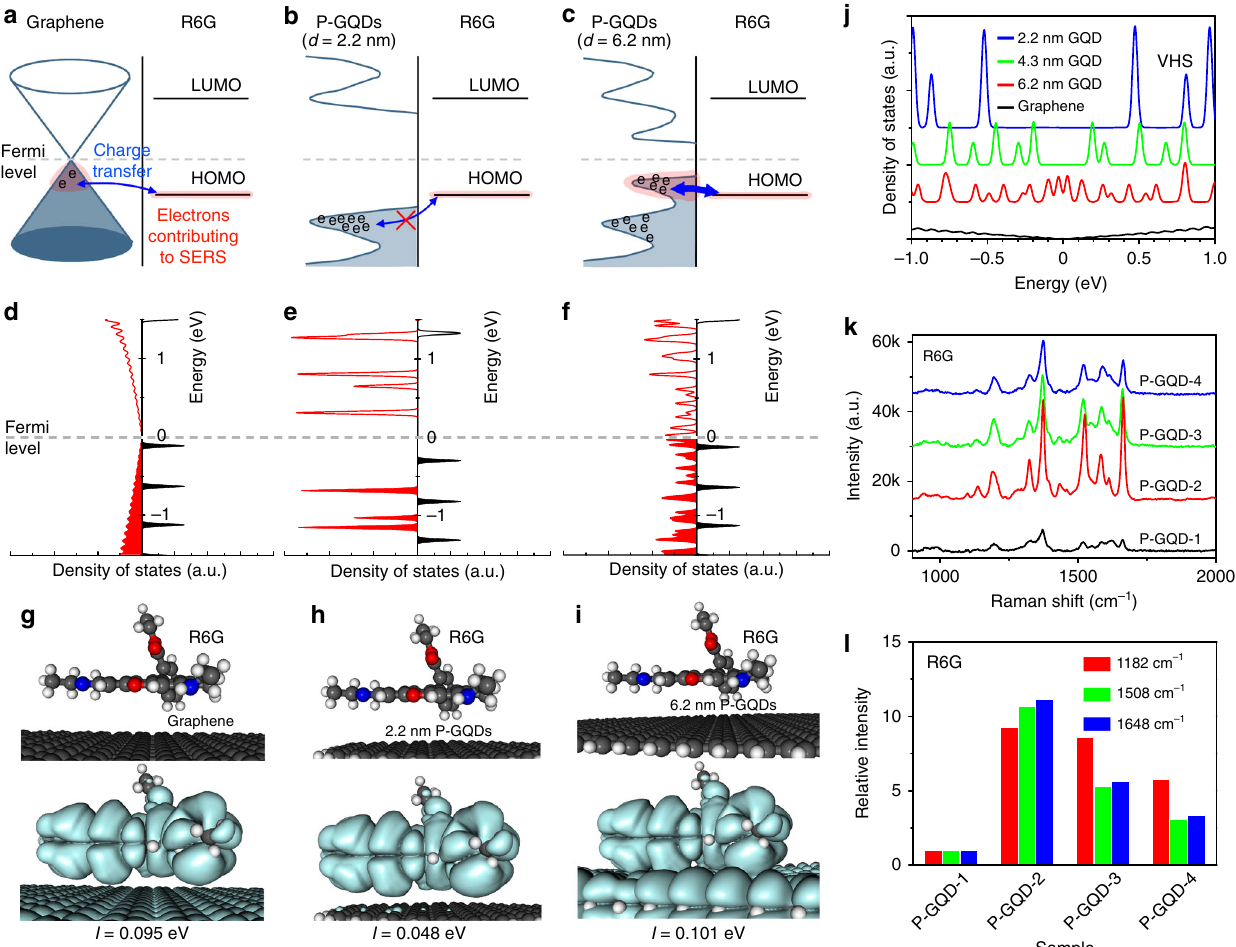
Fig. 4 The proposed enhancement mechanism and the size-dependent Raman enhancement for R6G. a – c The ground state charge transfer between R6G and graphene, GQDs (2.2 nm), or GQDs (6.2 nm). The electron states in the R6G/graphene (or GQD) system, which have the possibility to contribute to the surface-enhanced Raman spectroscopy (SERS), are marked by red shadows. d – f The calculated density of state (DOS) and g – i the calculated molecular orbital (at the HOMO level of R6G) densities of R6G/graphene, R6G/GQDs (2.2 nm), and R6G/GQDs (6.2 nm), respectively. ( g – i ) The atomic models used in the density functional theory (DFT) calculations and the calculated charge transfer integrals ( I ). j The calculated DOS of a graphene and GQDs with different diameters near Fermi level. k Raman spectra of thermally evaporated R6G on P-GQDs with different sizes. l Relative intensity of the characteristic peaks of R6G on P-GQDs with different sizes, normalized to the signals on SiO 2 /Si. The largest enhancement of R6G signal occurs on